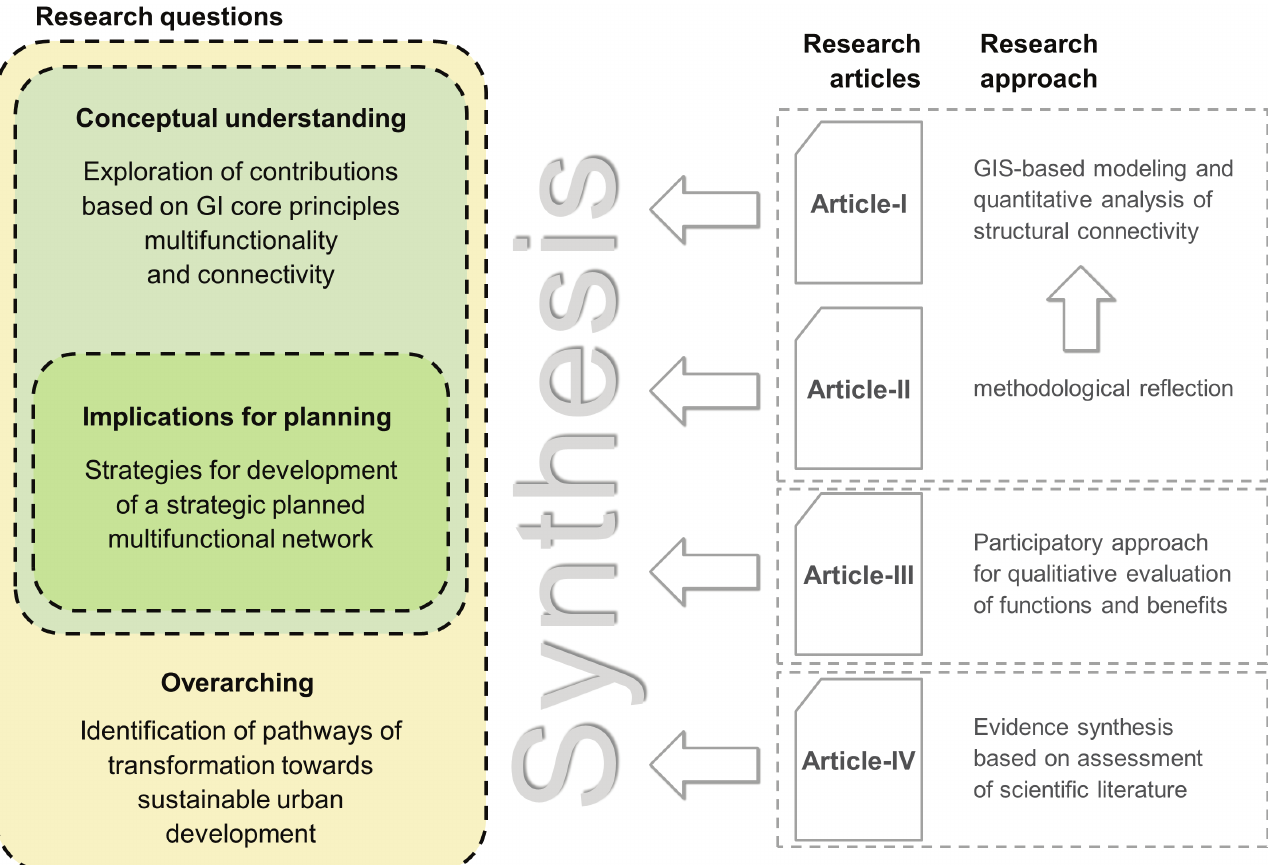
Figure 2. Structure of the thesis and with research approach and contributions of the articles to the research